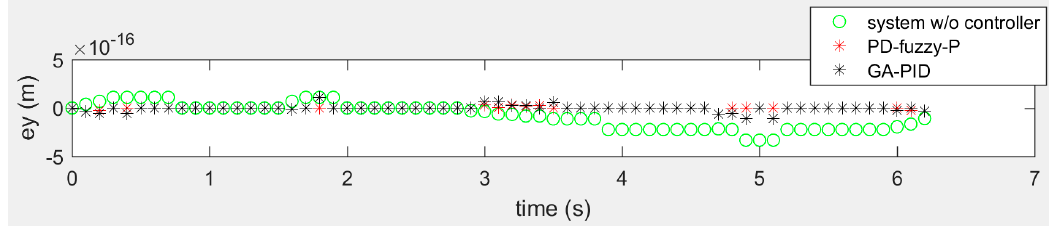
Figure 10. The error of the vertical motion of the rose shaped path in the global frame in meter.